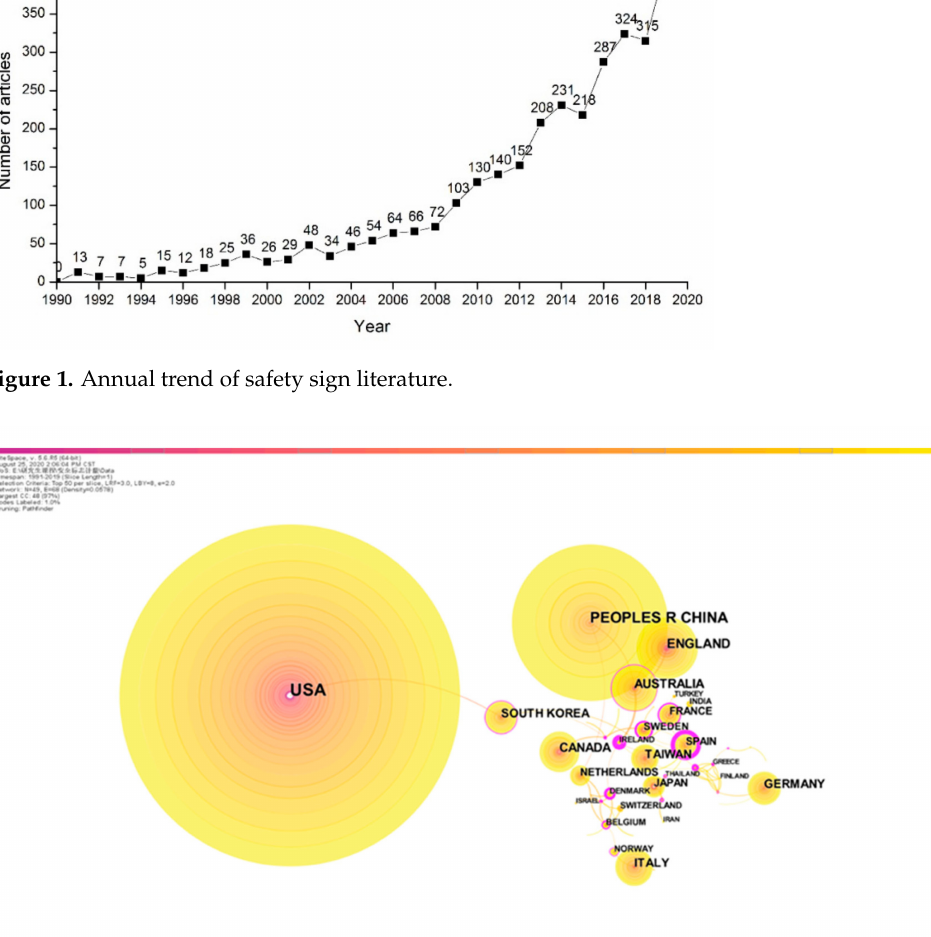
Figure 2. Countries or regions of safety signs research